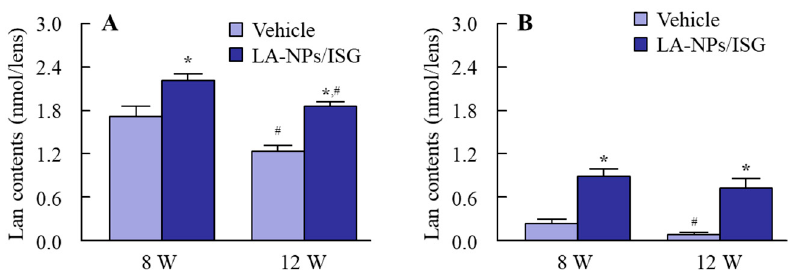
Figure 4. Lan contents of the lenses of SCR-N and SCR-C aged 8 and 12 weeks. ( A,B ) Changes in Lan content in the lenses of SCR-N ( A ) and SCR-C ( B ) repetitively instilled with LA-NPs/ISG. The repetitive instillations were performed twice per day from six weeks of age. Vehicle is solution consisting of BAC, mannitol, HPCD, and MC. n = 6. * p < 0.05, vs. Vehicle for each group. # p < 0.05, vs. 8 W for each group. The Lan content in the lenses of both SCR-N and SCR-C was increased by the repetitive instillation of LA-NPs/ISG. On the other hand, no corneal injury in the SCR repetitive instilled with LA-NPs/ISG was observed under the fluorescein stain.